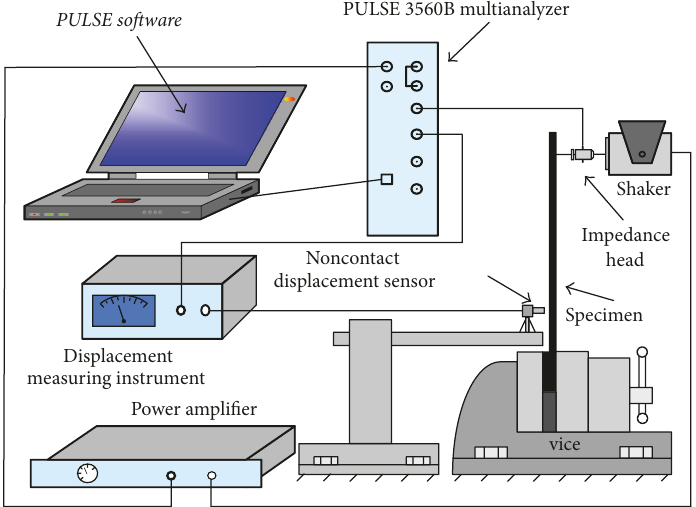
Figure 3: Experimental setup.